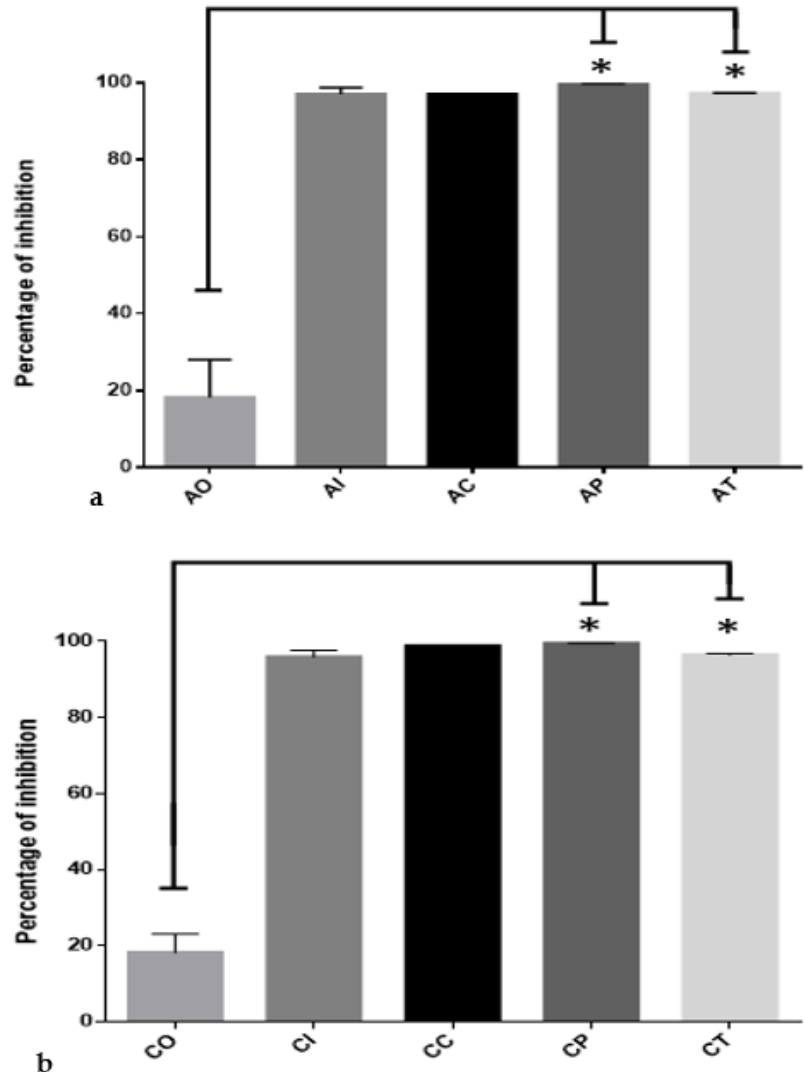
Figure 5. Inhibition of oxidative damage to hippocampal proteins exerted by curcumin against the ozone exposure in the acute and chronic phases: ( a ) the administration of dietary curcumin to the AP and AT groups significantly inhibited (* p < 0.0001) protein oxidation of hippocampal tissue in rats exposed to ozone when compared to the OA group, where oxidative damage was at the maximum level; acute O 3 (AO), acute intact (AI), acute CUR (AC), acute preventive (AP), acute therapeutic (AT); ( b ) this image depicts the effect of curcumin in preventive and therapeutic administration during chronic exposure to ozone; in both cases, the oxidative damage was markedly inhibited (* p < 0.0001) compared to damage determined in the chronic ozone-exposure control group (CO); chronic O 3 (CO), chronic intact (CI), chronic CUR (CC), chronic preventive (CP), chronic therapeutic